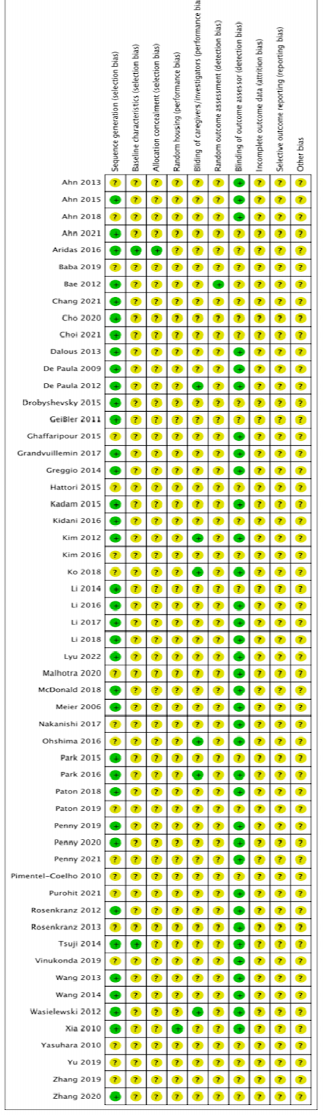
Figure 6. Systematic Review Centre for Laboratory Animal Experimentation (SYRCLE) risk of bias assessment.